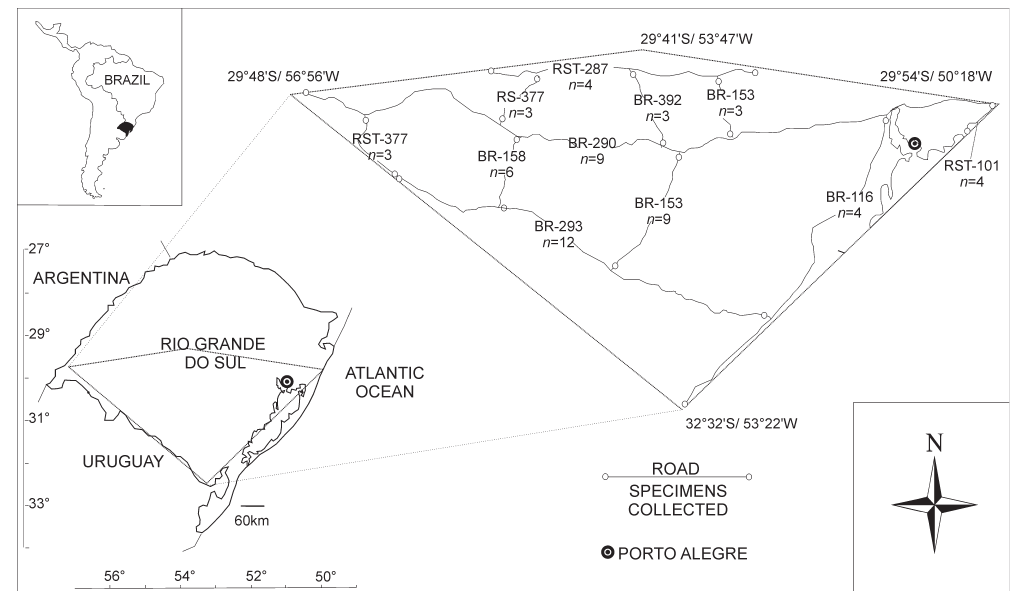
Figure 1. Location of the study area, sampled roads and number of specimens collected per